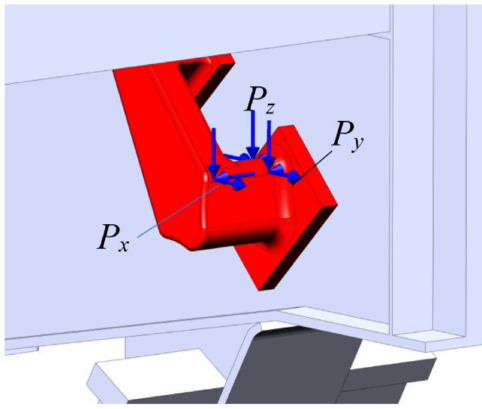
Figure 12. Application of the forces from a chain binder to the fixation unit.